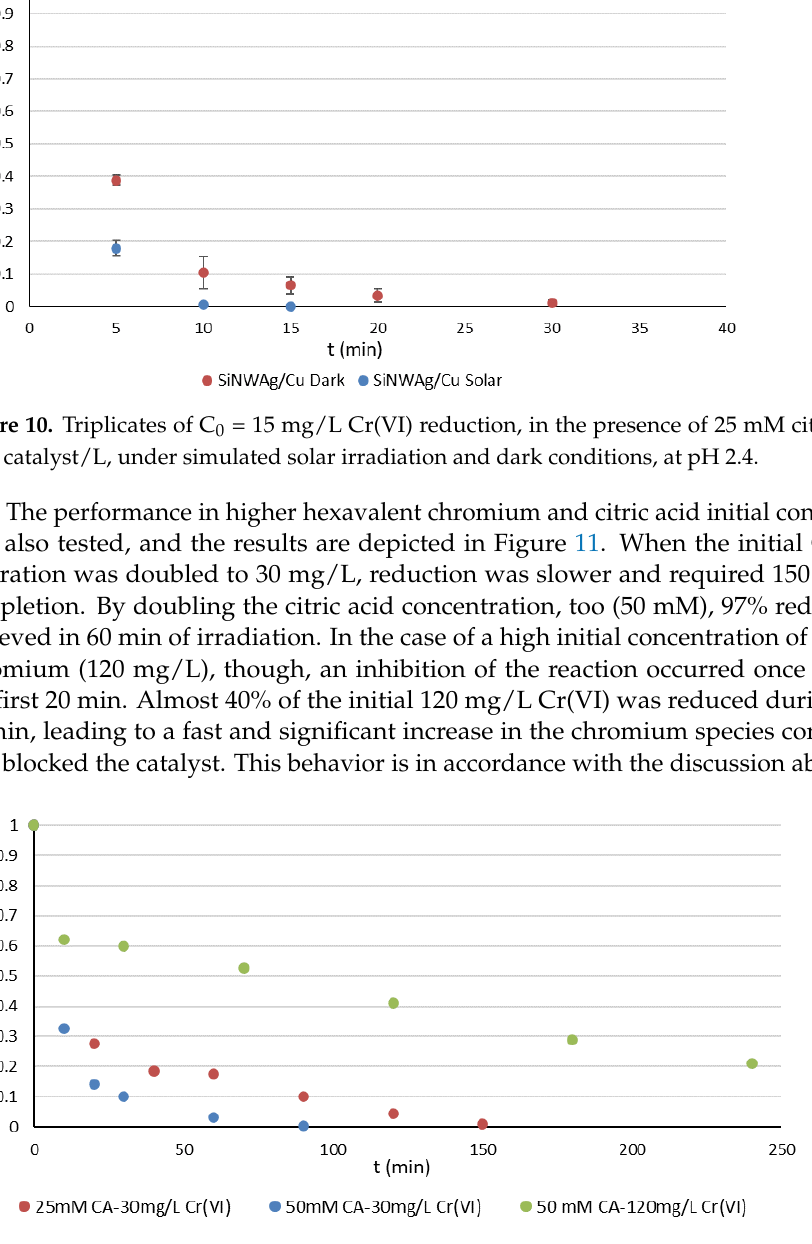
Figure 11. Cr(VI) C/C 0 ratio of different initial hexavalent chromium and citric acid (CA) concentra- tions, using 1.2 g catalyst/L, under simulated solar irradiation.